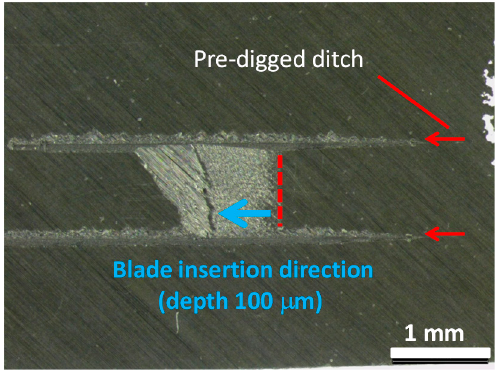
Figure 4. Cutting diagonally from the surface of CFRP sample by using the surface and interfacial cutting analysis system (SAICAS).